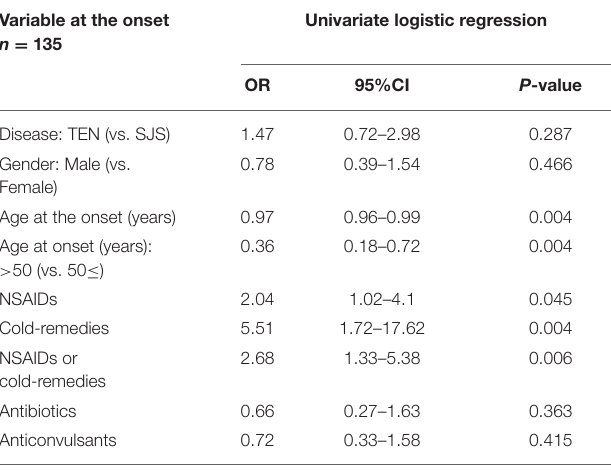
TABLE 1 | Univariate Logistic Regression Analysis Of The Association Between Variables At Onset And Acute Ocular Severity In The Patients with Stevens-Johnson syndrome (SJS) and toxic epidermal necrolysis (TEN) [modified version of the table presented in (4)]. Variable at the onset n = 135